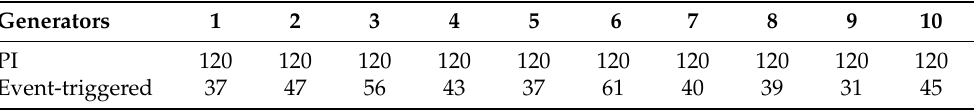
Table 5. Comparison of iteration times between two